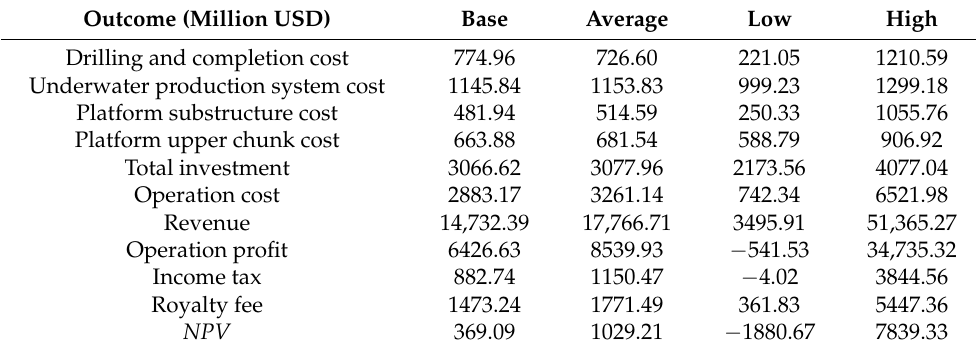
Table 3. The outcome of the integrated economic evaluation model.